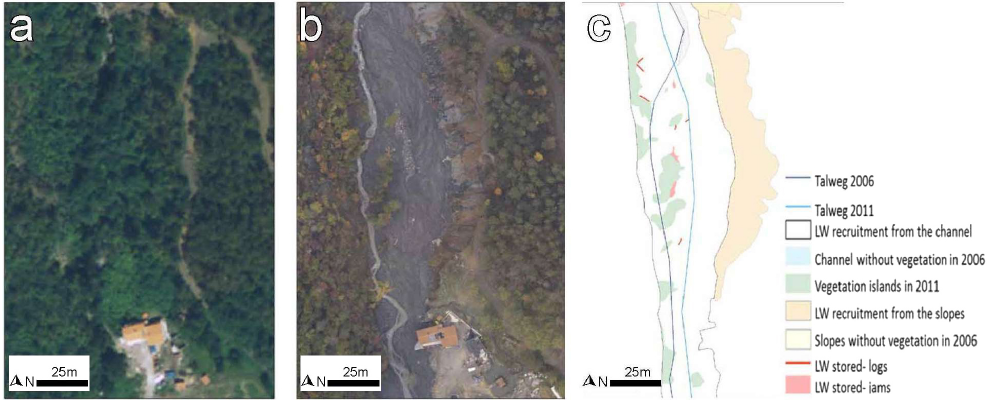
Figure 3. A reach in the Casserola 1 channel (Gravegnola) before (a) and after (b) the October 2011 event and the GIS mapping (c)